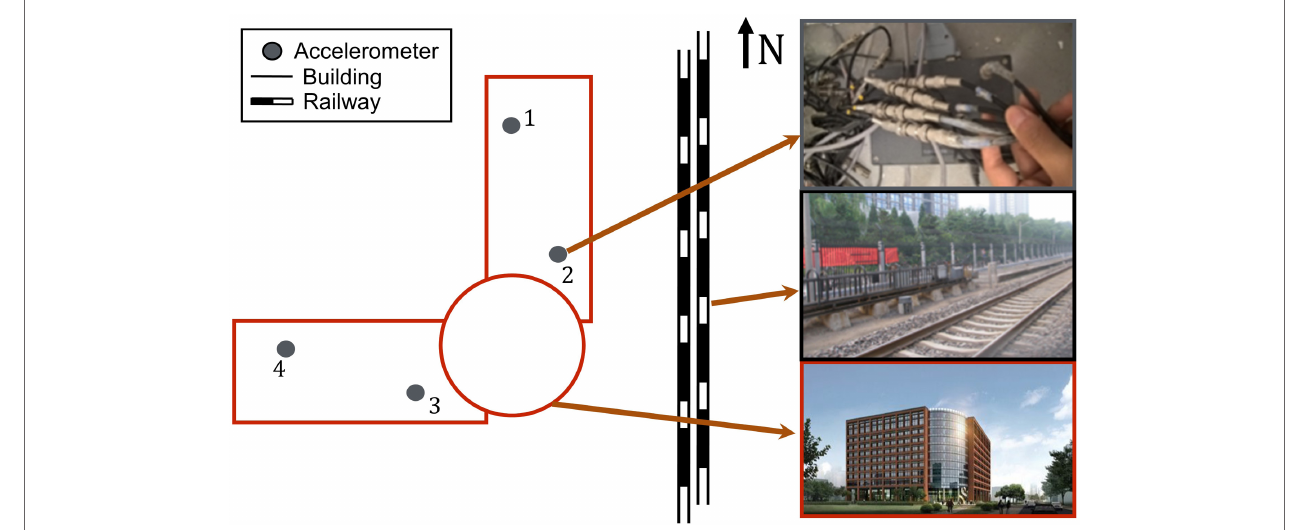
FIGURE 3 | Building, location of train track, and sensor deployment (vertical view)